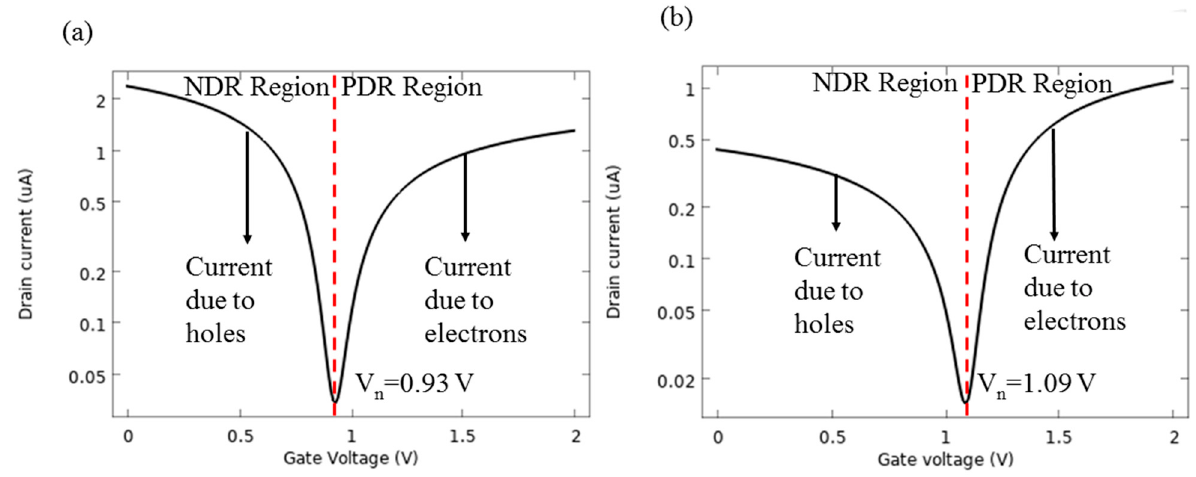
Figure 7. I–V characteristics show two distinct regions and the particular V n for ( a ) AlP-GFET, ( b ) Pd-GFET.